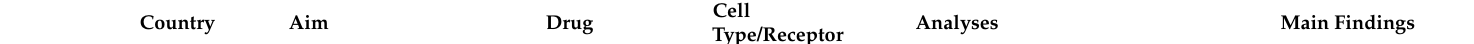
Table 2. Study and drug characteristics from included